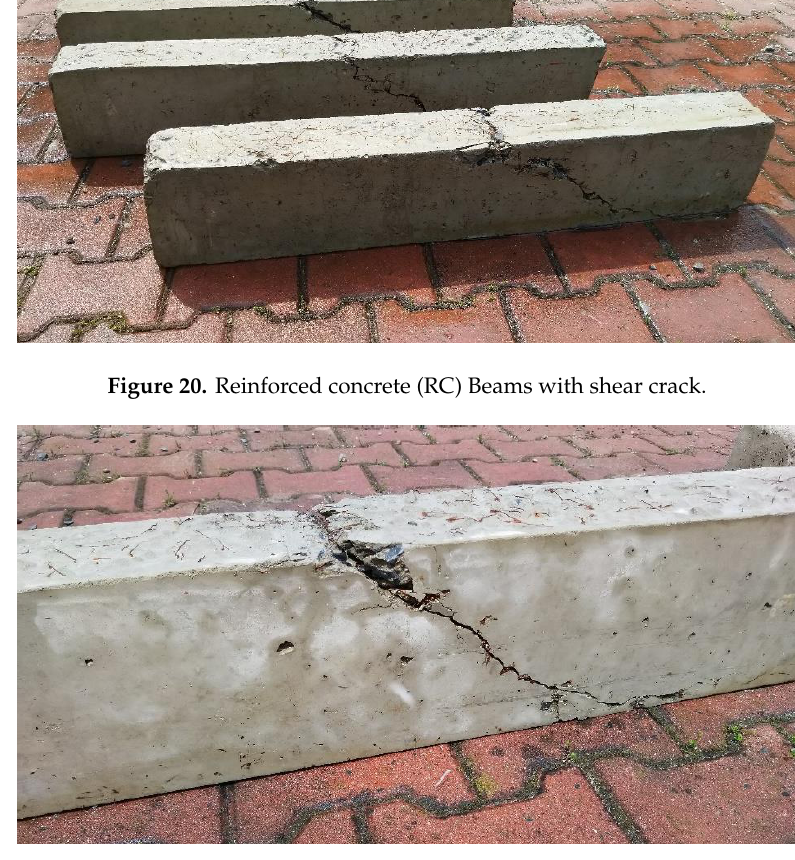
Figure 21. Details of a shear crack.